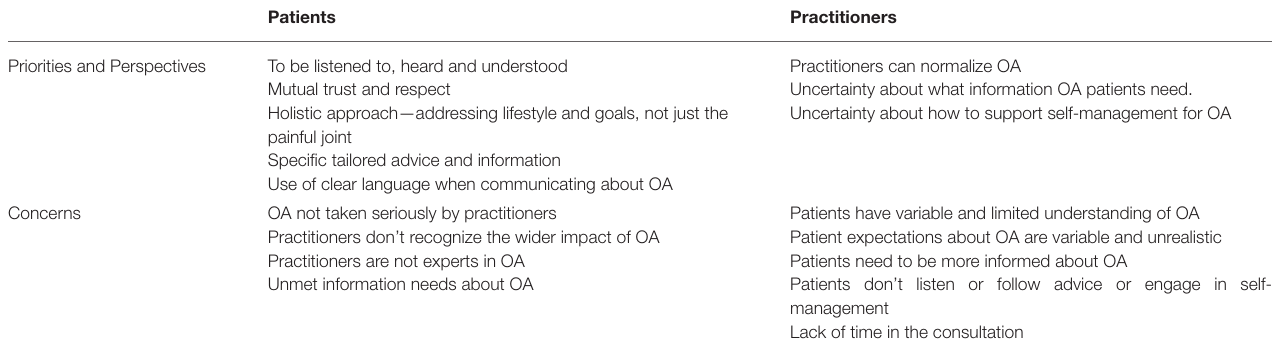
TABLE 3 | Themes identified in the meta-ethnography.